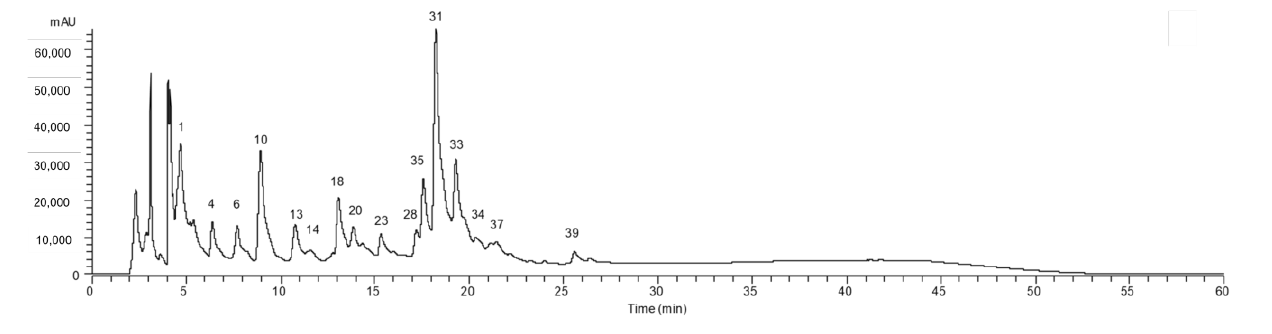
Figure 1. Phenolic profile of the pulp of Aesculus hippocastanum recorded at 280 nm. Peak numbering is indicated as defined in Table 2.